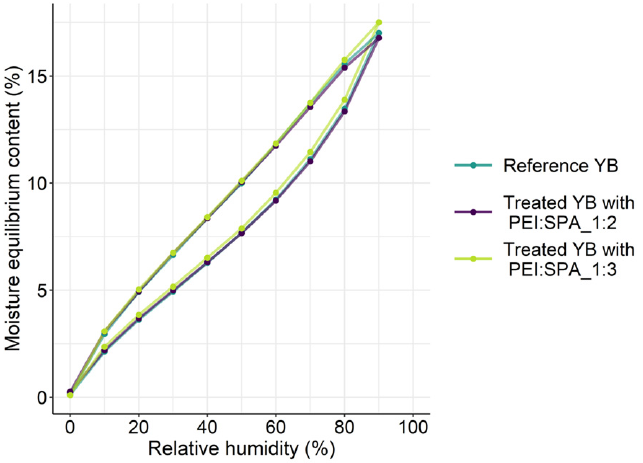
12 Figure 12. Isotherms for reference yellow birch and treated yellow birch with two different PEC